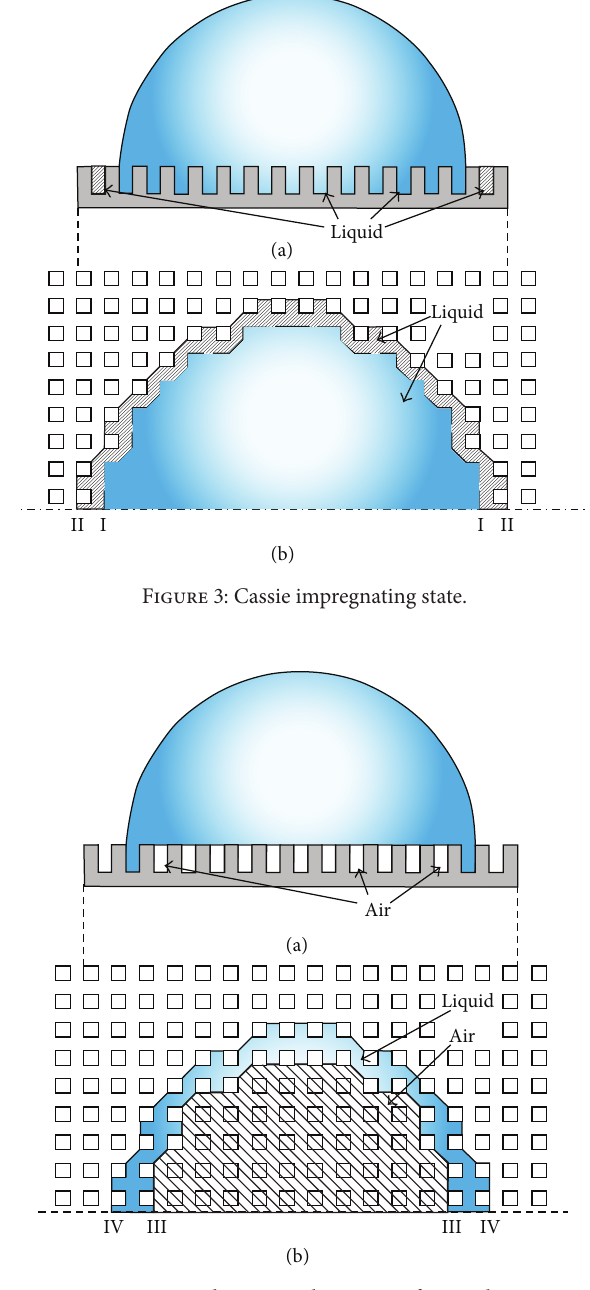
Wenzel state). Therefore, the effect of deformation of contact line was